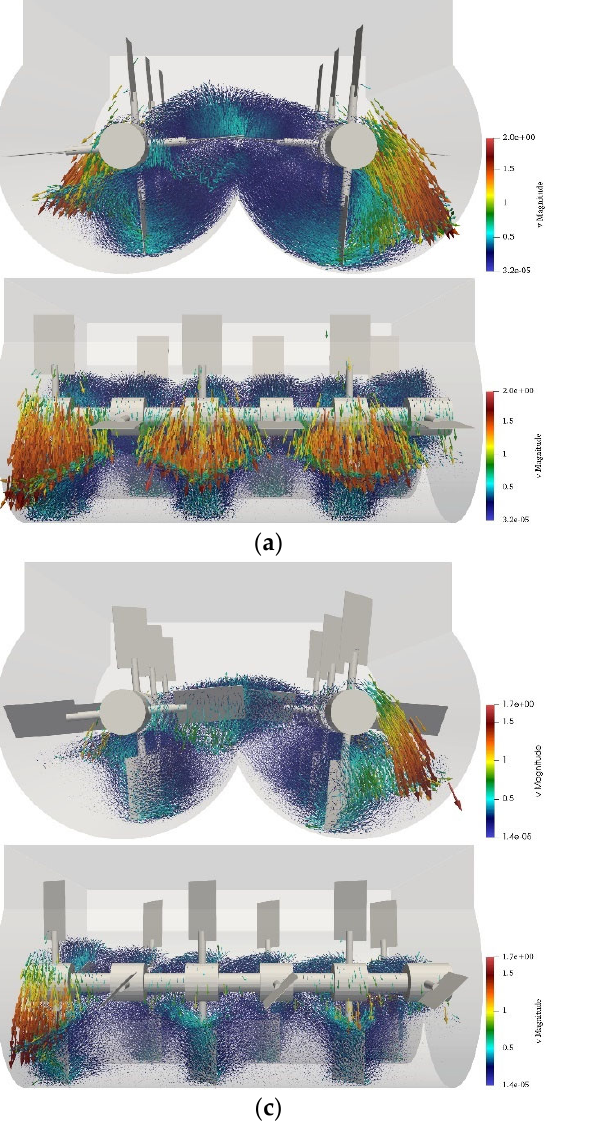
Figure 11. Spatial particles’ velocity distribution at t = 30 s: ( a ) 0°; ( b ) 30°; ( c ) 45°; ( d ) 60°.